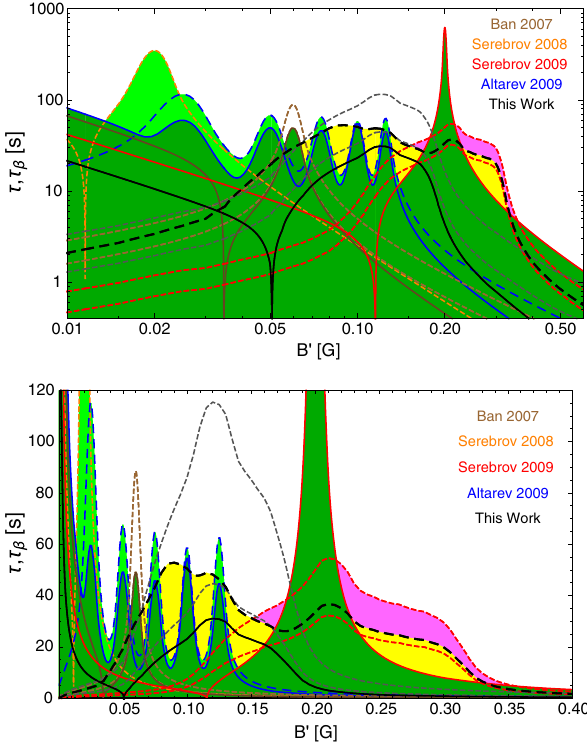
Fig. 7 upper panel: our lower limits on τ (black solid) and τ β (black dashed). The parameter areas excluded by the previous experiments are shaded in dark green for τ and light green for τ β while the yellow shadedareacorrespondstonewregionsexcludedinthiswork(allexclu- sion limits correspond to 95 % C.L.). Solid red curve corresponds to lower limit on τ from experiment Serebrov et al. [60] while dashed red contours confine 2 σ region of τ β relevant for 5 . 2 σ anomaly in vertical magnetic fields with B c = 0 . 2 G [60,63]. The wavy blue curves show lower limits on τ (solid) and τ β (dashed) from the results of Altarev et al. [61]. Orange dashed contour corresponds to the limit from Sere- brov [58]. Solid brown curve corresponds to lower limit on τ from experiment Ban et al. [57] while the dotted brown curves confine 2 σ region for τ β relevant for 3 σ deviation of A B in the same experiment. The parameter areas relevant for these anomalous deviations that are not excluded are shaded in pink. Dashed grey contours confine the 2 σ parameter region corresponding to 2 . 5 σ deviation in our measurements of B 2 series. Lower panel: the same in linear scale, as the blow up of the exclusion regions covered by our experiment and previous